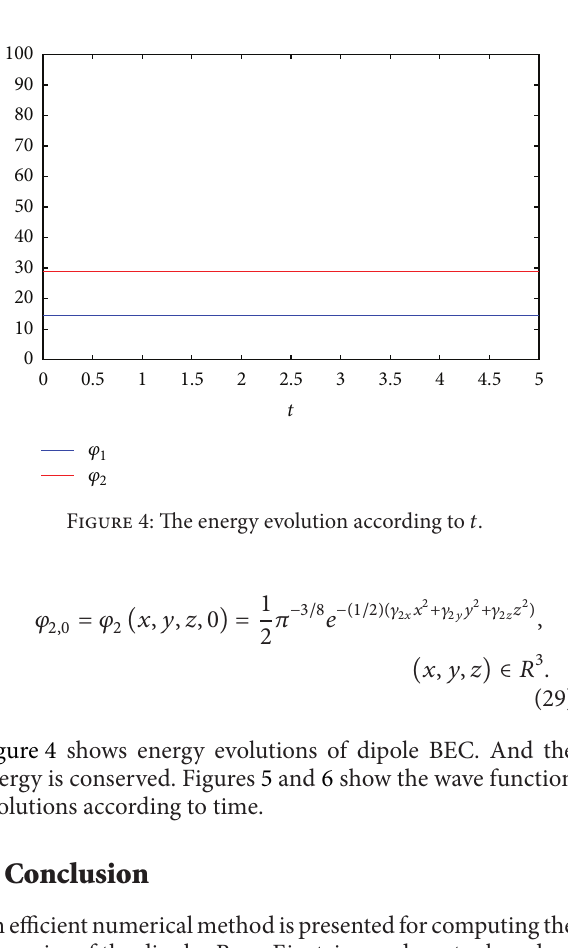
Figure 3: The wave function evolution according to time. Surface plots for |𝜑 2 (𝑥,0, 𝑧, 𝑡)| 2 at different times.